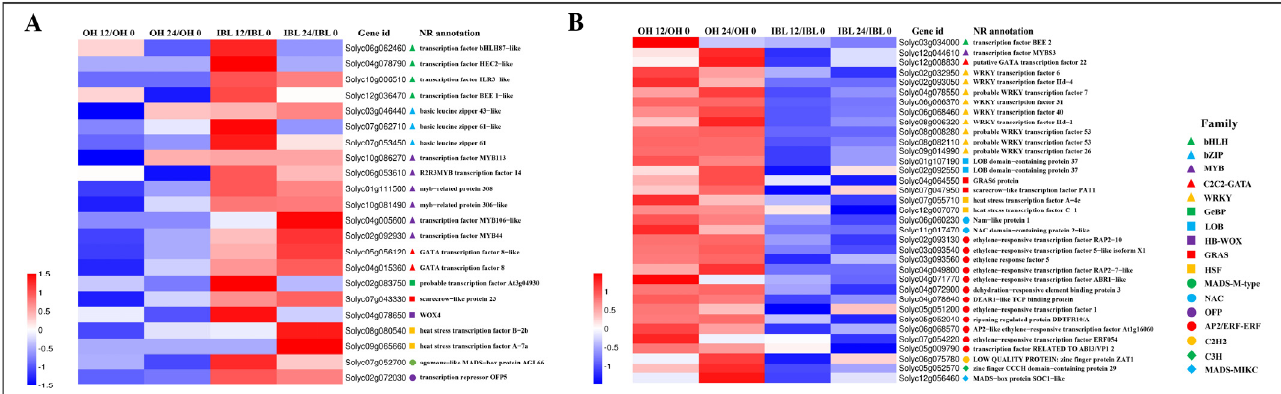
Figure 5. Heat maps exhibiting the expression profiles of resistance-related differentially expressed- transcription factor genes. ( A ) TFs up-regulated in IBL2353. ( B ) TFs down-regulated in IBL2353. Data were the Log2 value of gene expression fold changes and were normalized based on Z-score formula. The blue color means the value was lower than the mean of 4 Log2 values from two lines at two time-points, and not the down-regulation. The red color means the value was higher than the mean of 4 Log2 values from two lines at two time-points, but not up-regulation. The darker color represents the higher deviation from the average. OH 12/OH 0 and OH 24/OH 0 represent the ratio of gene expression value at 12 hpi and 24 hpi compared to value at 0 hpi in Ohio88119, respectively; IBL 12/IBL 0 and IBL 24/IBL 0 represent the ratio of gene expression value at 12 hpi and 24 hpi compared to value at 0 hpi in IBL2353, respectively.